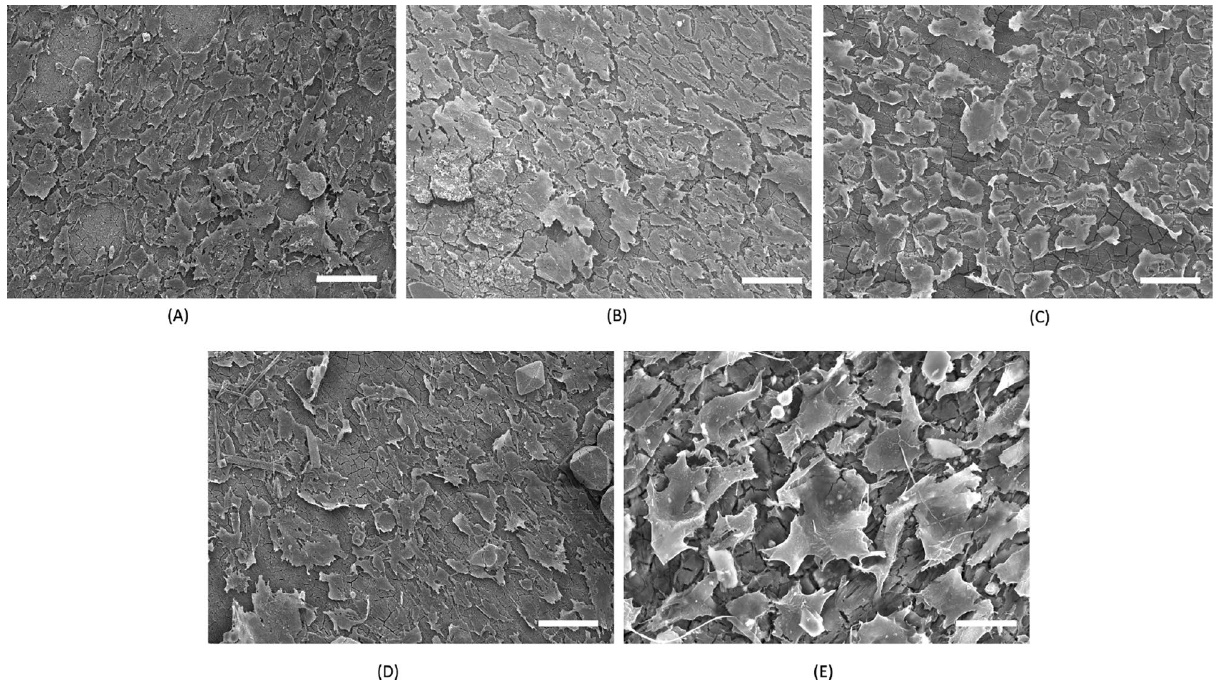
Figure 3. Cell cytoskeleton and morphology—Day 5 culture. After 5 days of direct culture, cells on all the discs were observed to be more flattened and well spread. Images of attachment of MC3T3-E1 cells on selected